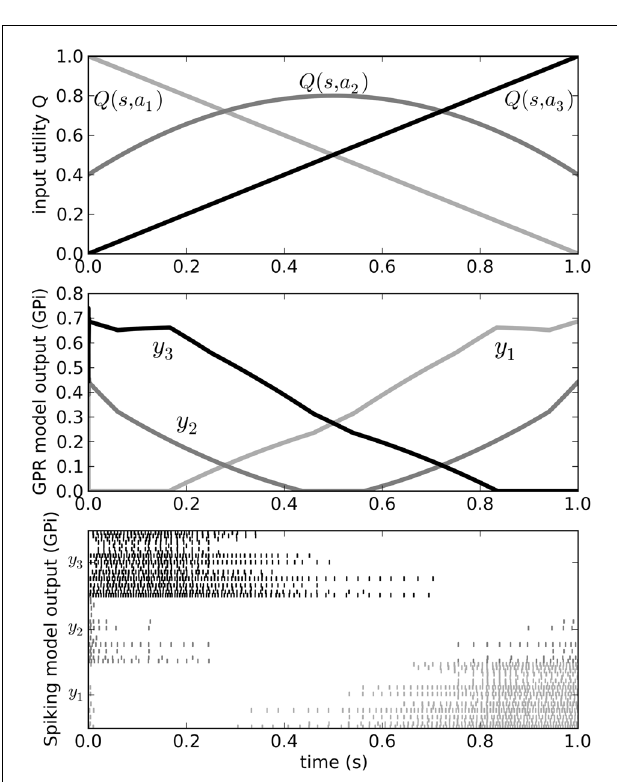
FIGURE 5 | Behavior of the original Gurney et al. (2001) model (middle) for a varying input (top). Spiking output from the GPi neurons in our model is also shown (bottom).Varying input corresponds to changing the utilities Q of the three actions a 1 , a 2 , and a 3 as the current state s changes over time. Since the output from the GPi is inhibitory, the neurons corresponding to the chosen action should stop firing when that action’s Q -value is larger than that of the other